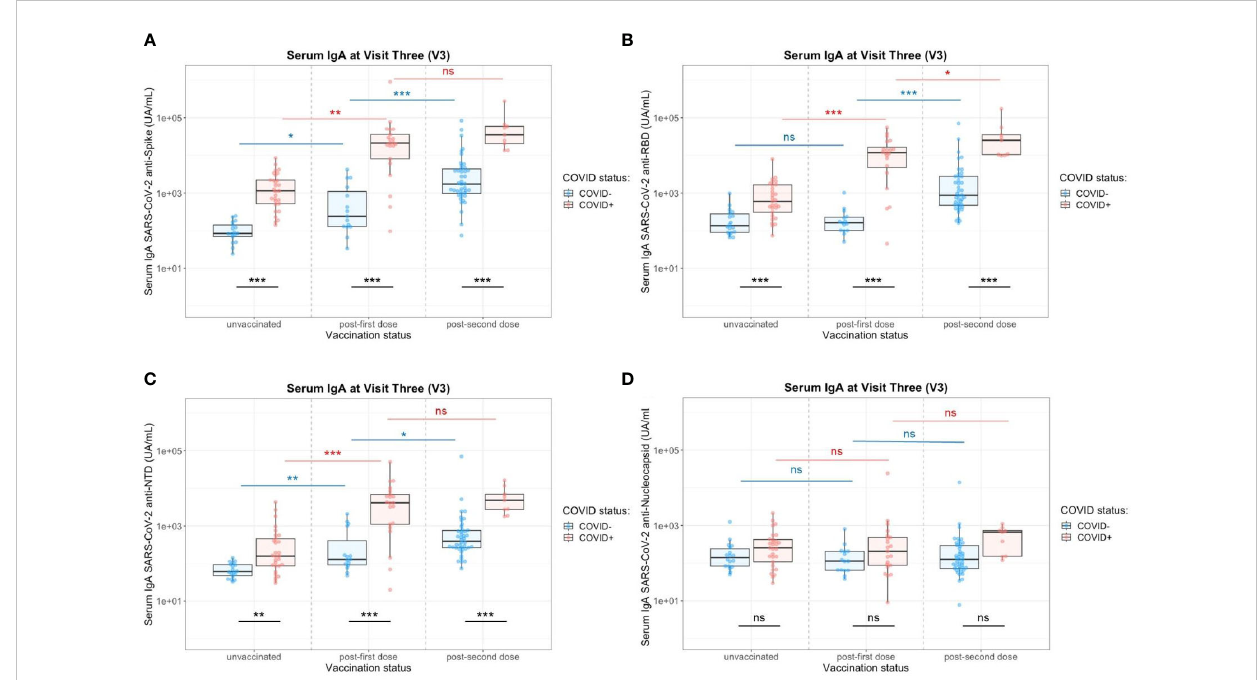
FIGURE 5 Impact of the number of vaccine doses on serum anti-SARS-CoV-2 IgA titers in the presence (red) or absence (blue) of a previous COVID-19 infection. (A) Serology IgA titers against the whole Spike. (B) Serology IgA titers against the Spike/RBD. (C) Serology IgA titers against the Spike/NTD. (D) Serology IgA titers against the Nucleocapsid. Two-Way ANOVA tests with Tukey post ’ hoc test: ns, not signi fi cant; * p<0.05; ** p<0.001; *** p<0.001.